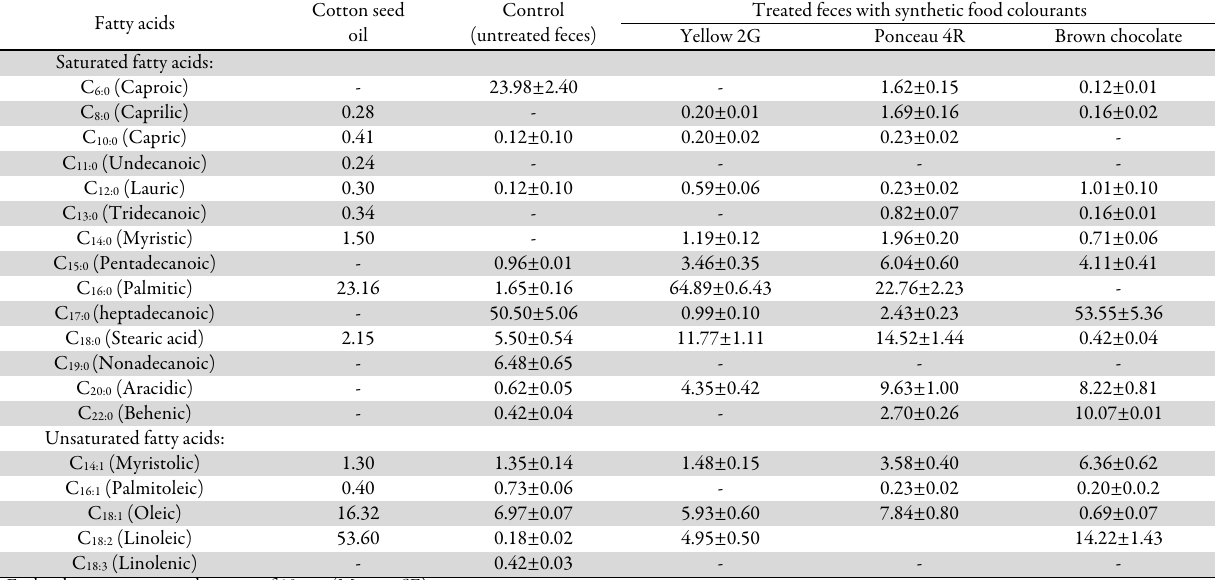
Table 2. Relative percentage of fatty acids in rat feces affected by synthetic food colourants Fatty